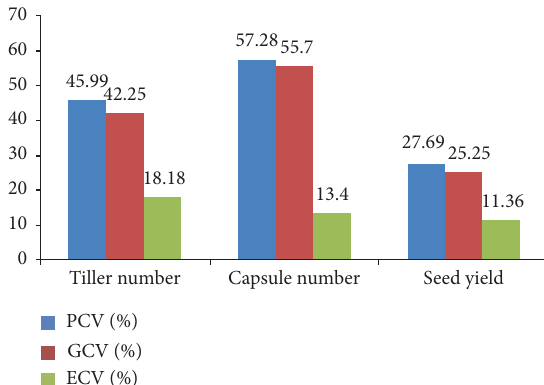
Figure 5: Comparative values of phenotypic, genotypic, and en- vironmental coefcients of variation for tiller number, number of capsules per plant, and seed yield combined over the two